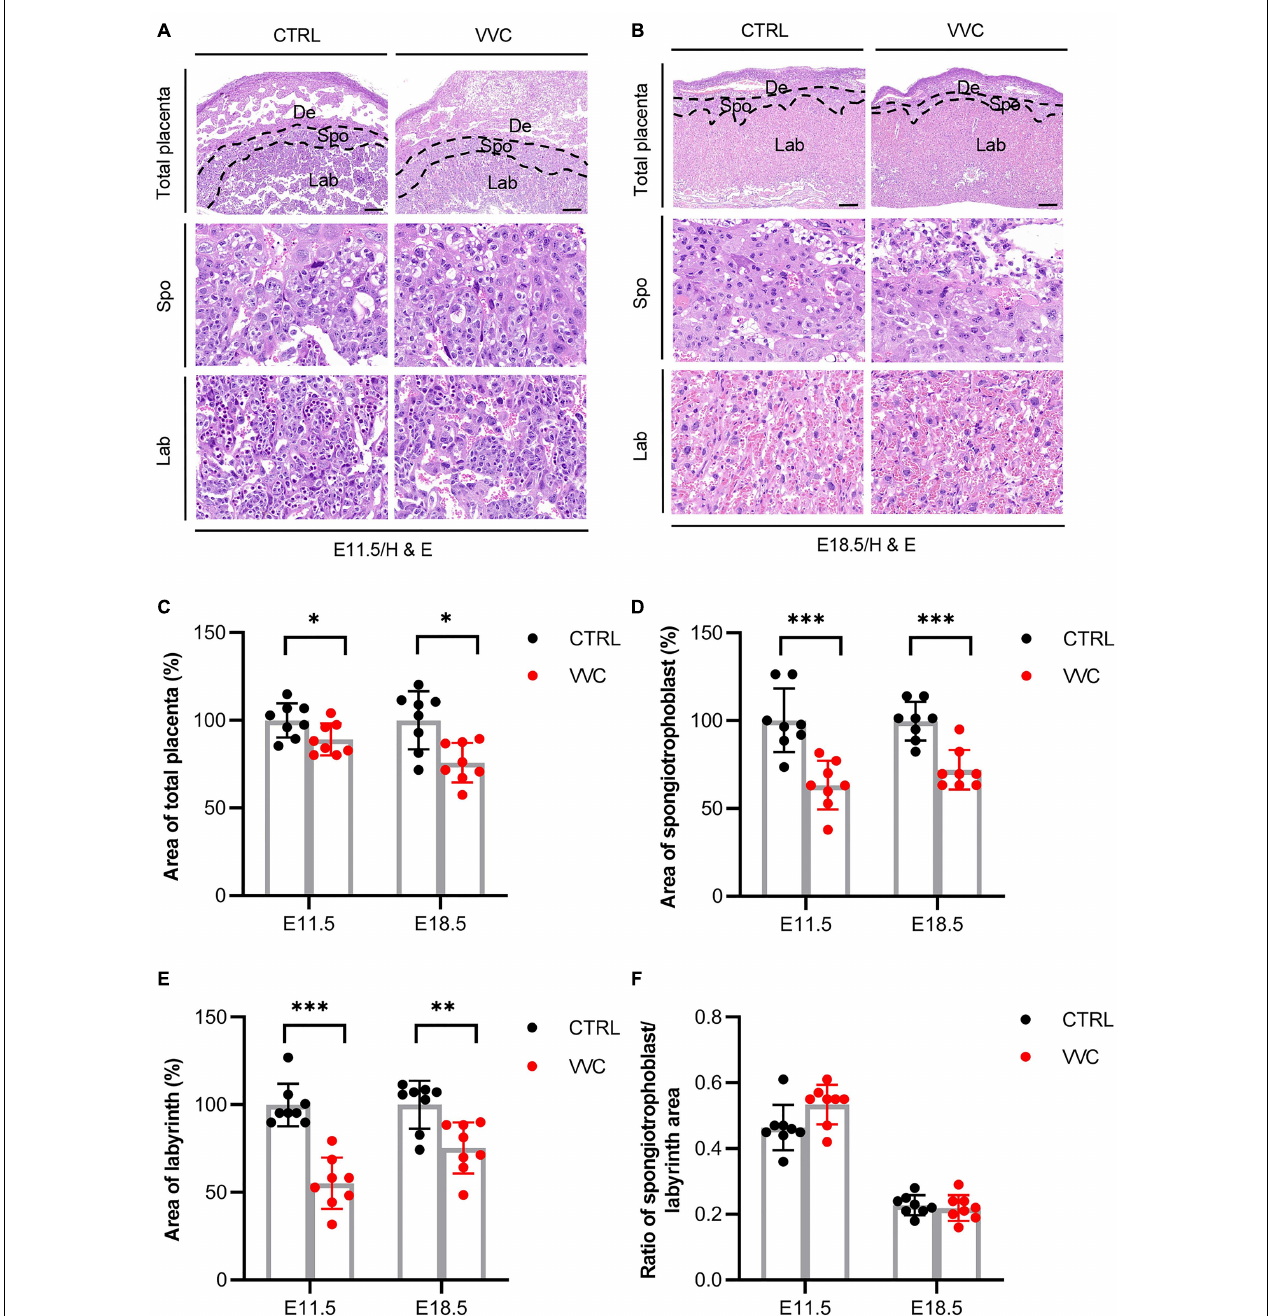
FIGURE 4 | Effect of Vaginal C. albicans infection on placental structure. (A,B) Representative images of placental section observed by H&E staining at E11.5 (A) and E18.5 (B) . Scale bar = 200 µ m. De, decidua; Spo, spongiotrophoblast; Lab, labyrinth. (C–F) Total area of placenta (%) (C) , area of spongiotrophoblast (%) (D) , area of labyrinth (%) (E) , and the ratio of spongiotrophoblast to labyrinth area (%) (F) in placental tissue at E11.5 and E18.5. Data are presented as mean ± SD ( n = 8/group). Unpaired t -test was used for two-group comparisons. * p < 0.05, ** p < 0.01, *** p < 0.001 for VVC vs. CTRL.